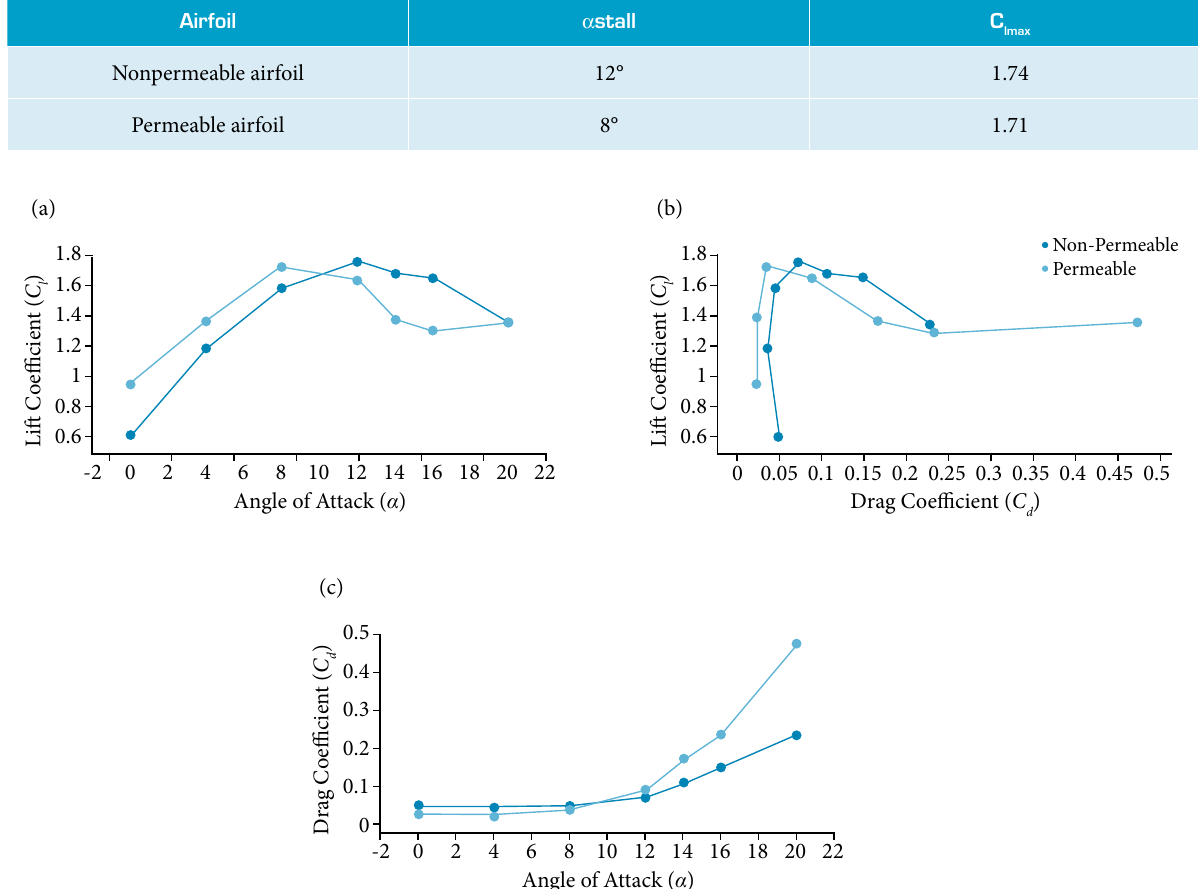
Figure 11. Variation of lift coefficient, drag coefficient and lift to drag ratio for nonpermeable and permeable